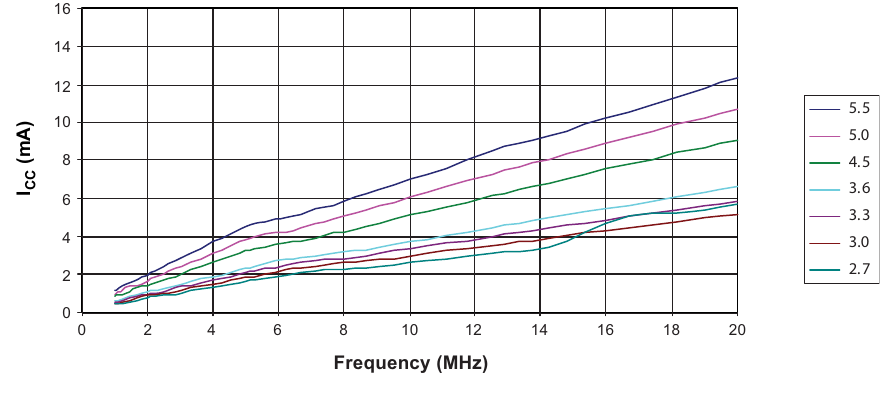
Figure 29-1. Active Supply Current versus Frequency